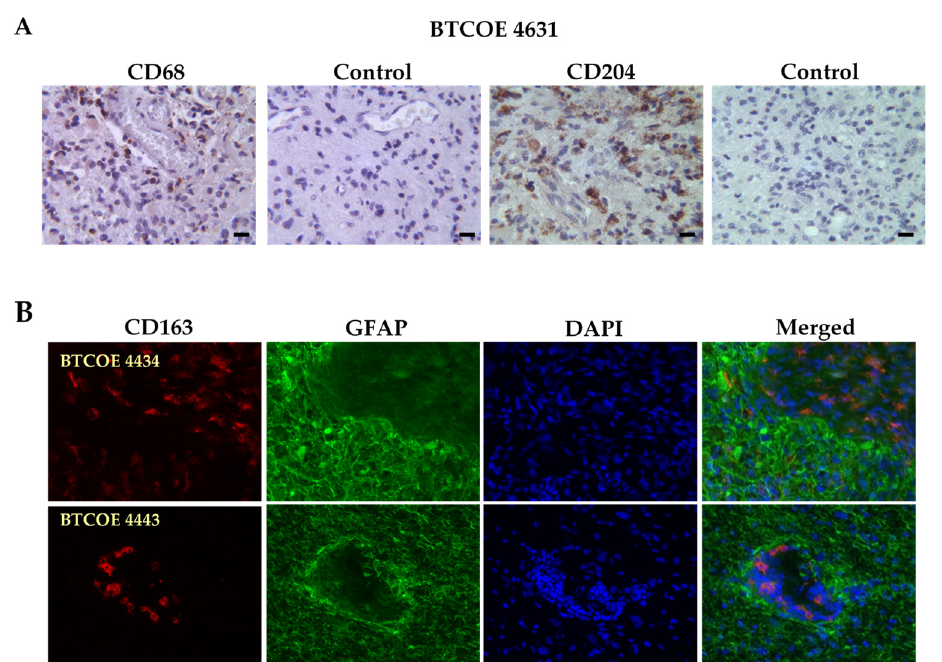
Figure 1. An abundance of M2 macrophages in GBM tumors. ( A ) BTCOE 4631 GBM sample stained for the pan-macrophage marker CD68 and the M2 macrophage marker CD204. ( B ) Representative images of the M2 macrophage marker CD163 (red), and the tumor cell marker GFAP (green) in GBM patient samples shows the presence of M2 macrophages both within tumors and the tumor vasculature. Scale bars for all images are 50 μ m. These images are representative of over 10 patient tumor specimens tested.